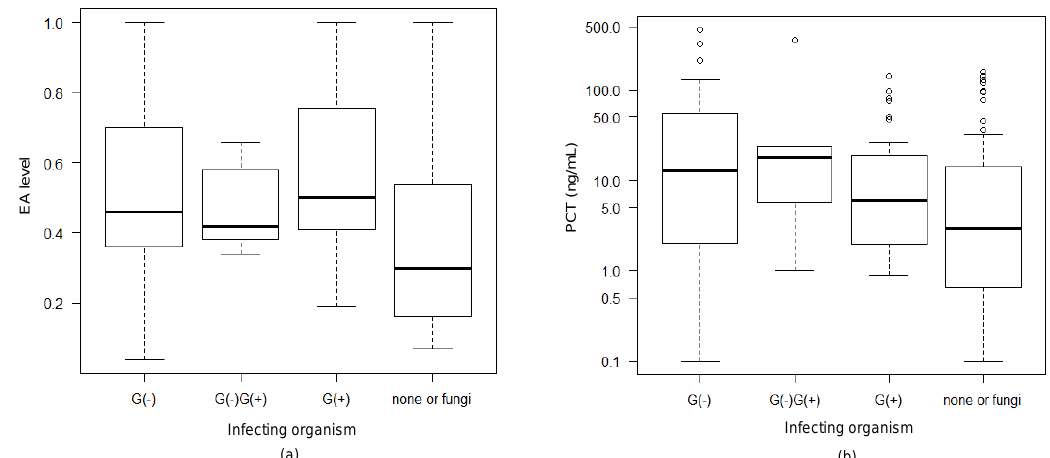
Figure 5. Association between the infecting organisms and biomarkers. ( a , b ) Comparisons between the EA level ( a ) and PCT level ( b ) among various types of infecting organisms: Gram-negative bacteria alone [G(-)], a mixture of both Gram-negative and Gram-positive bacteria [G(-)G( + )], Gram-positive bacteria alone [G( + )], and other (none or fungi). The data were analyzed by a Mann–Whitney U test. PCT levels tended to be higher in patients infected with Gram-negative bacteria, whereas EA levels did not show any detectable di ff erence between patients infected with Gram-negative or Gram-positive